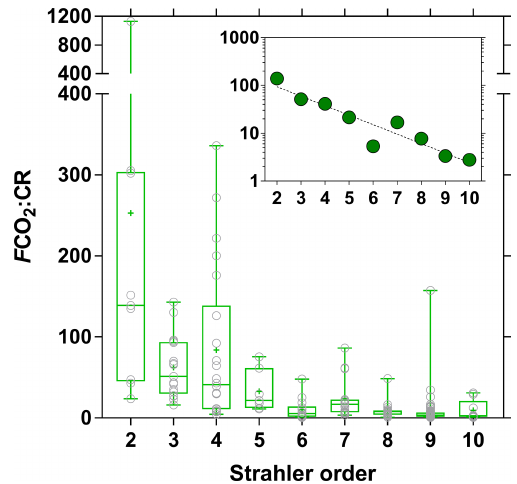
Figure 16. Ratio of air–water CO 2 fluxes ( F CO 2 in mmolm − 2 d − 1 ) and community respiration (mmolm − 2 d − 1 ) as a function of Strahler stream order for rivers and streams of the Congo River network. The box represents the first and third quartile, the horizontal line corresponds to the median, the cross corresponds to the average, the error bars correspond to the max- imum and minimum, and the symbols show all data points. Inset shows on a log scale the median of F CO 2 :CR and an exponential fit ( r 2 = 0 .